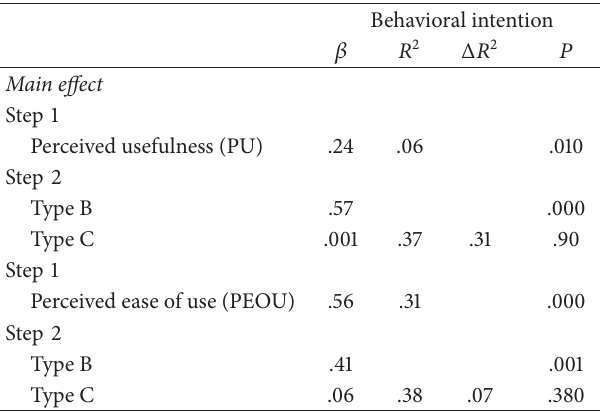
Table 10: Mediation analysis of designers’